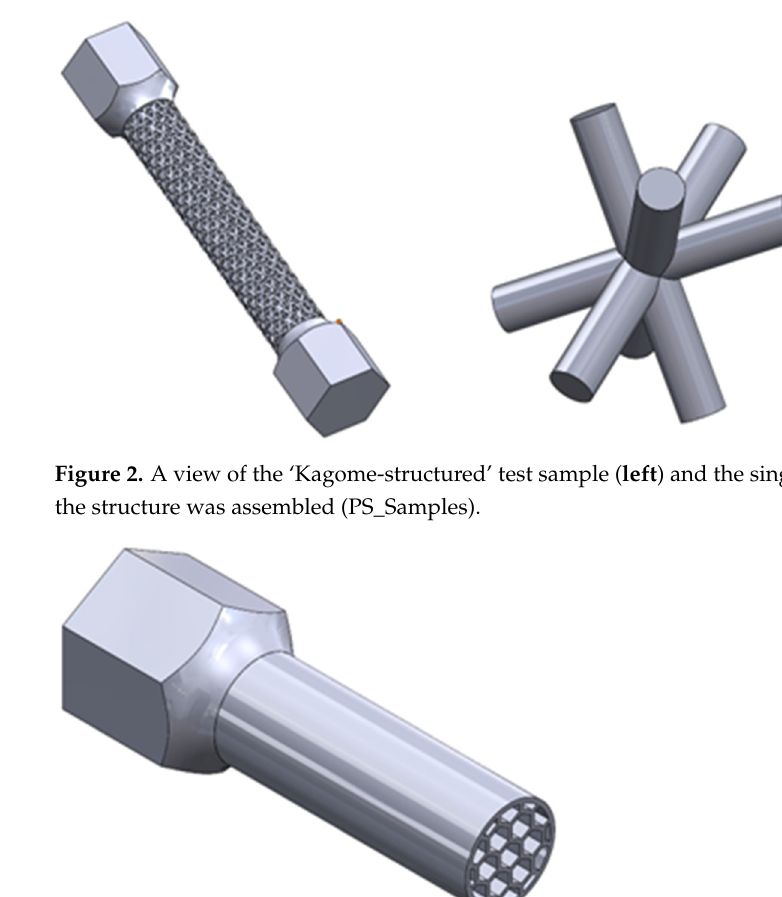
Figure 1. Monolithic specimen (PM_Samples).